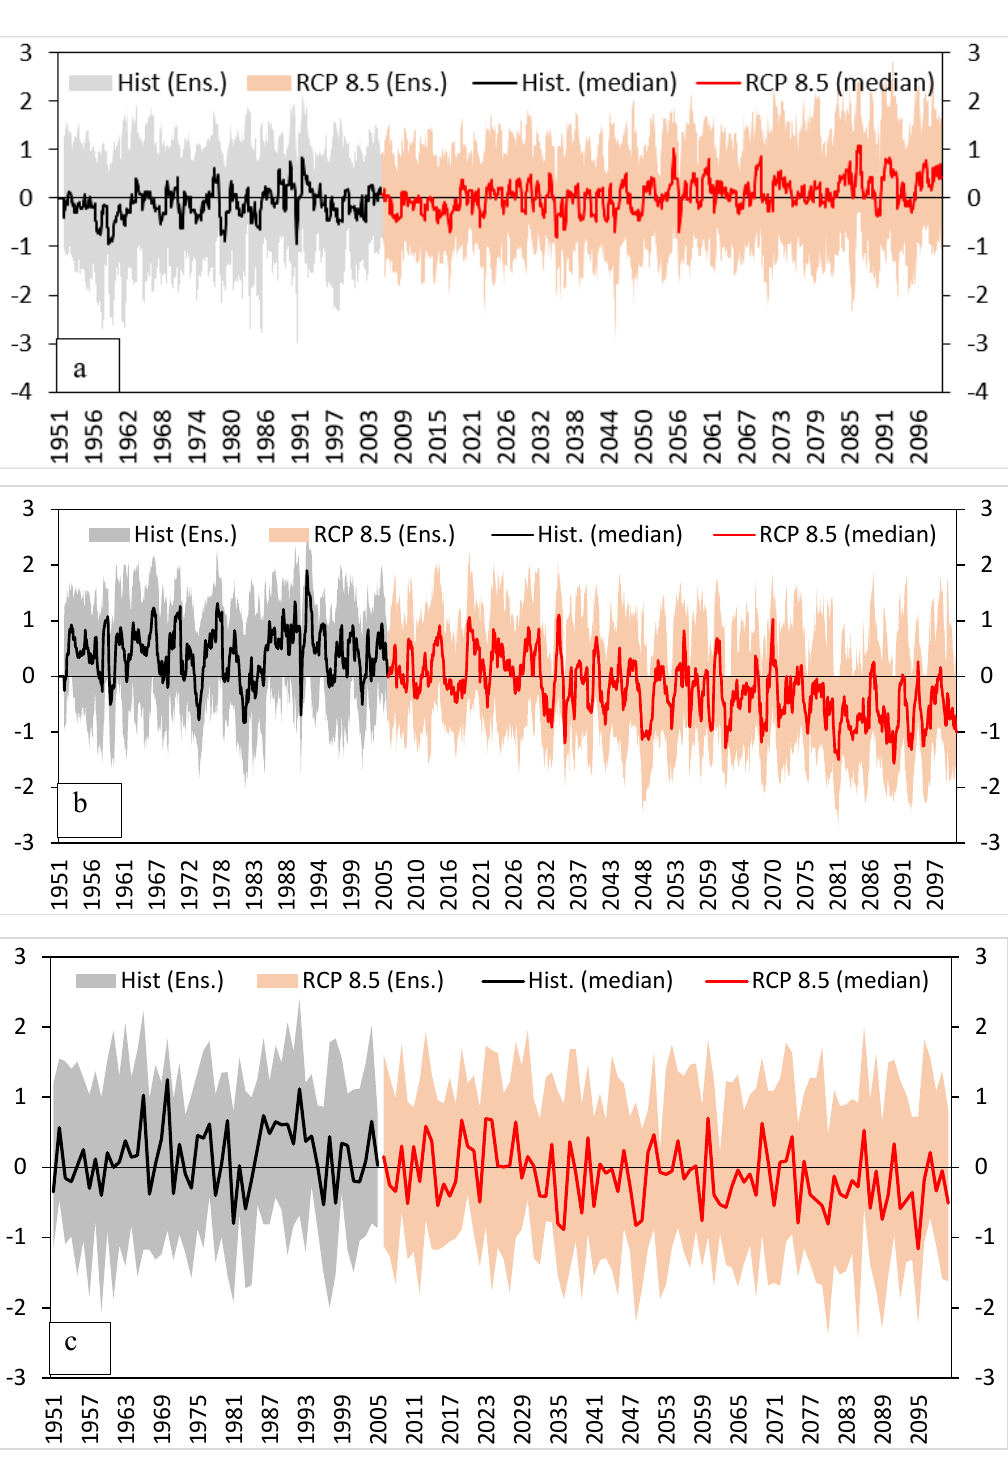
Figure 5. Historical and projected future changes in 12-month drought intensity over Nigeria for RCP 8.5 climate scenario. The droughts are characterized using ( a ) SPI; ( b ) SPEI; and ( c )